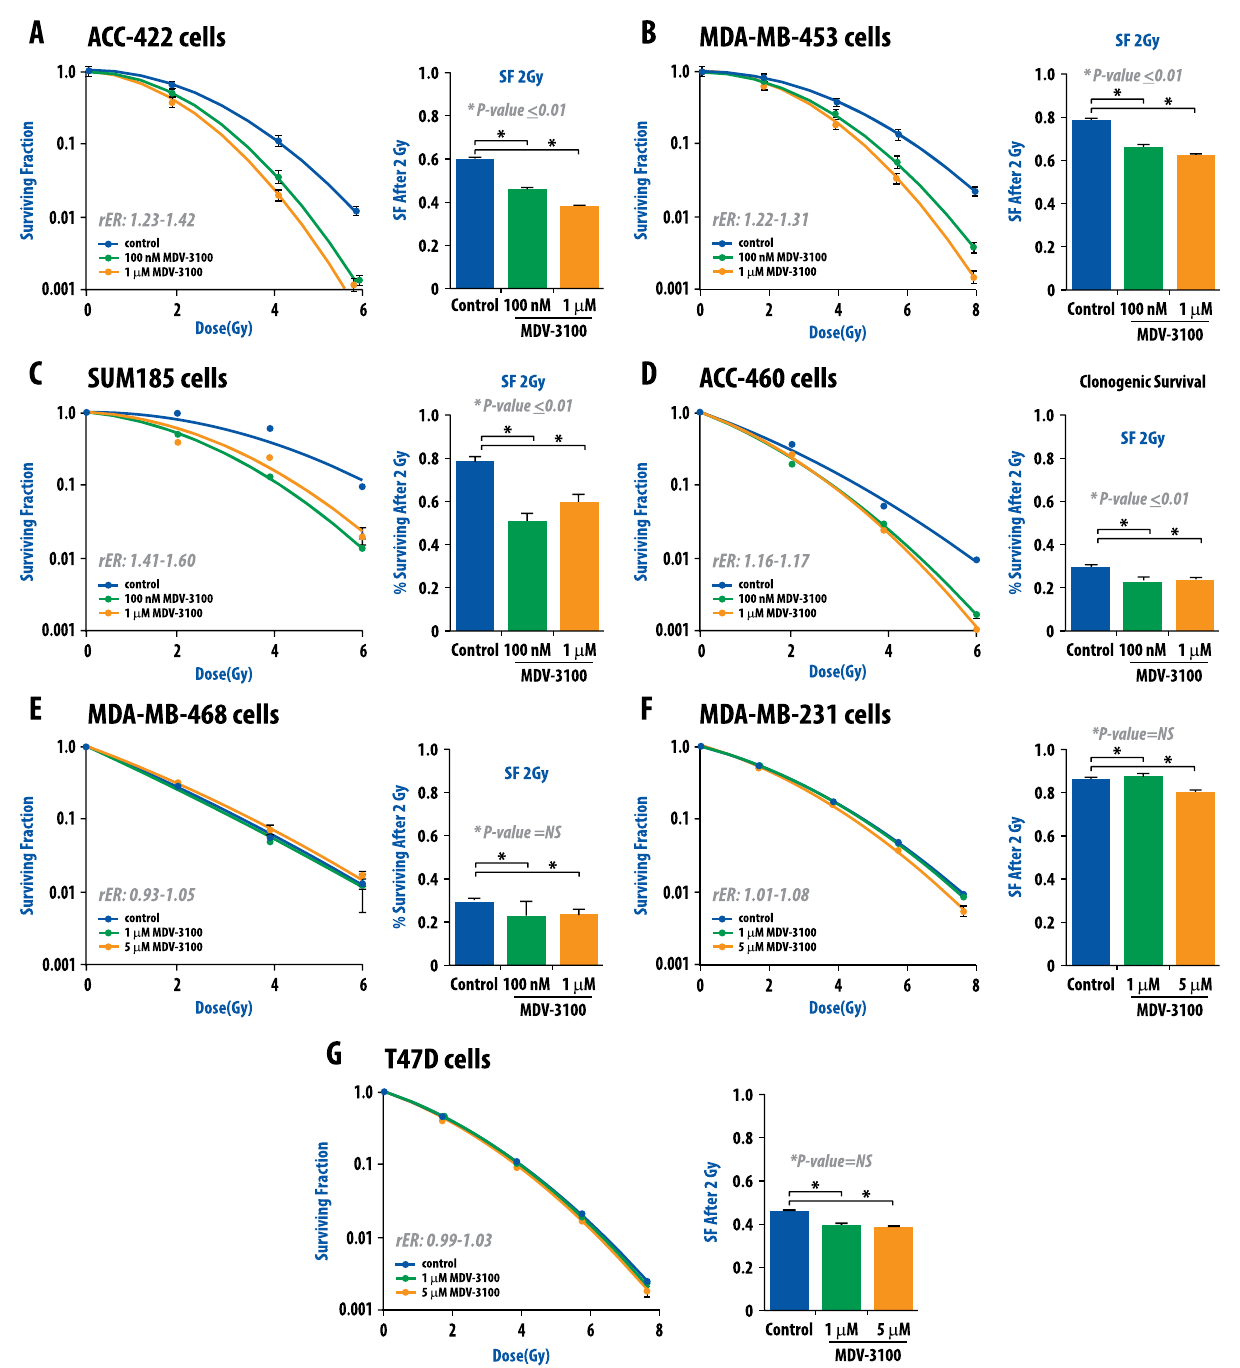
TNBC were selected and treated with varying doses of ionizing radiation and MDV3100. Clonogenic survival assays were performed and both surviving fraction after 2 Gy and enhancement ratios were calculated ( a – d ). Treatment with MDV3100 effectively radiosensitized the LAR